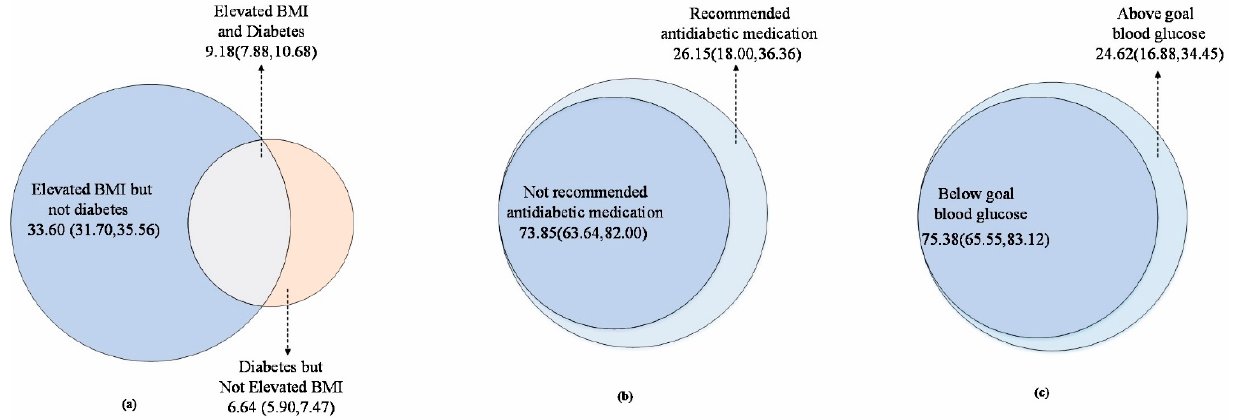
Figure 1. Data used for estimating were from CHARLS 2011–2012 baseline survey. ( a ) Percentage of Chinese adults who have elevated BMI, diabetes, or both. ( b ) Proportion of patients who are not taking antidiabetic medication and who have diabetes combined with elevated BMI. ( c ) Proportion of people taking antidiabetic medication with diabetes combined with elevated BMI and whether their blood glucose reaches the target.